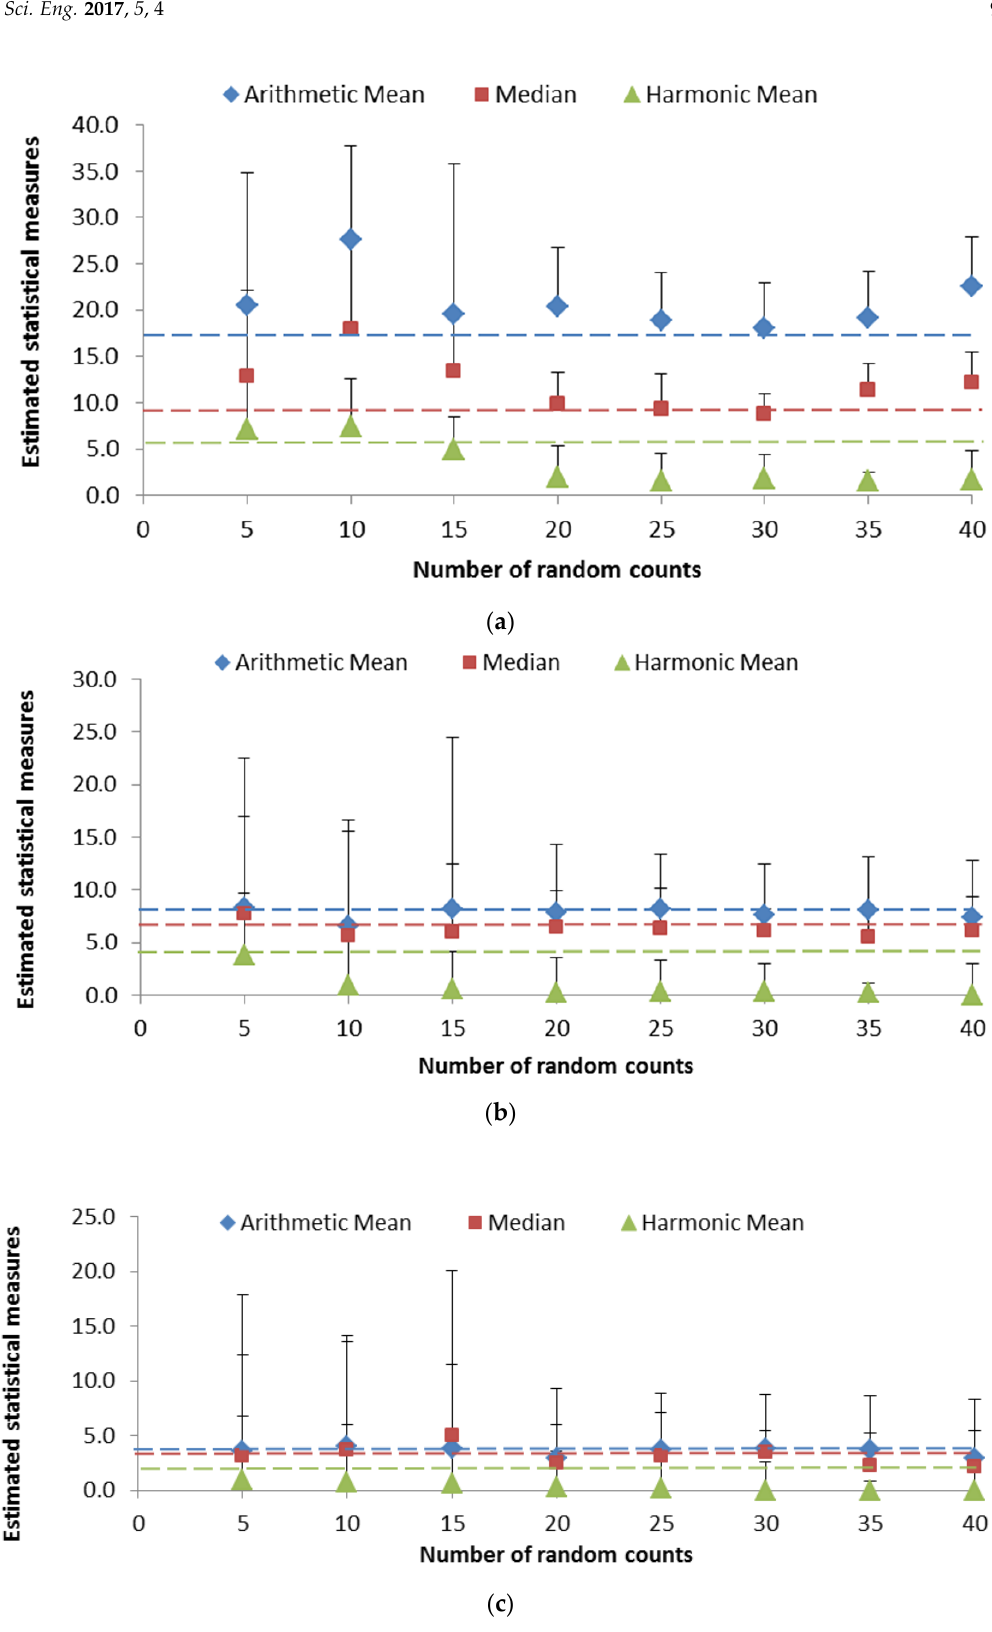
Figure 5. Estimated values of arithmetic mean, median and harmonic mean based on random counts obtained from samples, ( a ) S1, ( b ) S2 and ( c ) S3 (as denoted in figure above) using bootstrapping technique ( n = 5, 10, 15, 20, 25, 30, 35 and 40 each of 1000 iterations with replacement). Vertical bars indicate the standard deviation in counts. Broken straight lines indicated in same colour as data points, refer to the actual value of the corresponding statistical measure calculated from the original count matrix of each sample (13,924 fields of view).